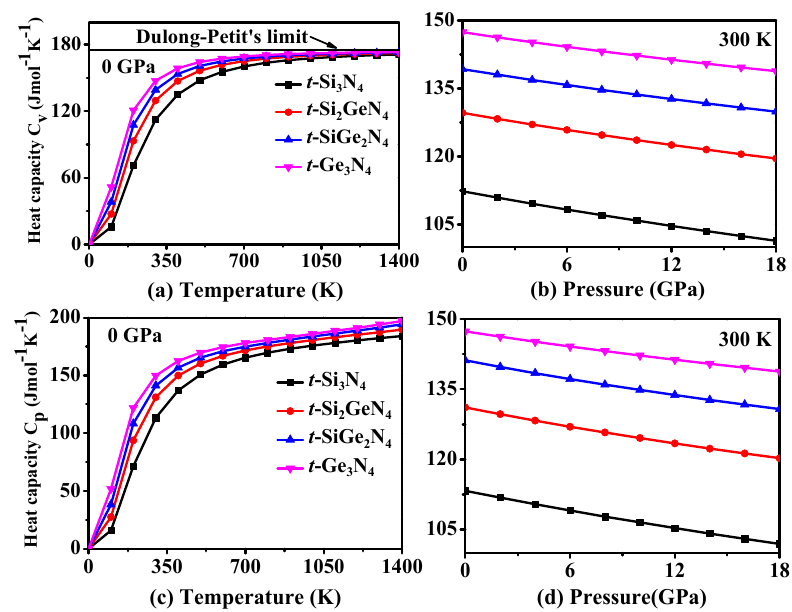
Figure 8. Temperature ( a ) and pressure ( b ) dependence of the thermal expansion coefficients for t -Si 3 N 4 , t -Si 2 GeN 4 , t -SiGe 2 N 4 , and t -Ge 3 N 4 .